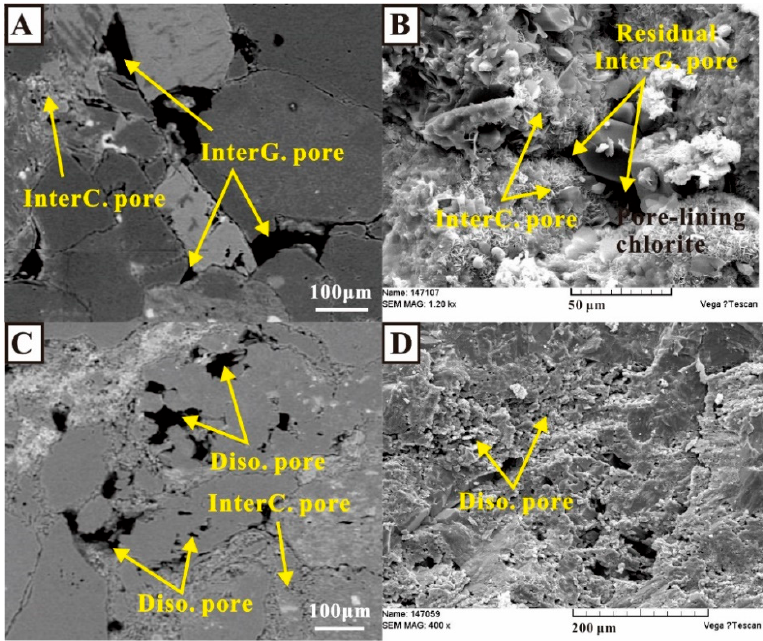
Figure 4. Pore types of tight gas reservoirs in the Xujiaweizi Rift, identified by SEM images. InterC. = intercrystalline; InterG. = intergranular; Diso. = Dissolution. ( A ) Sample #1; ( B ) sample #3; ( C ) sample #6; ( D ) sample #6.